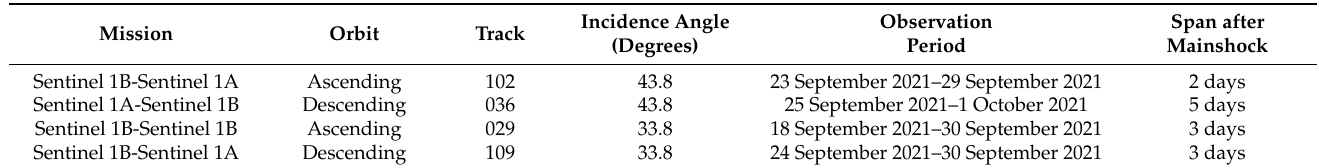
Figure 4. Co-seismic LoS displacement maps, as derived using GEP DIAPASON service, for ascending October 2021) ( c , d ) and the corresponding wrapped differential interferograms ( e , f ). The spatial extend of Sentinel-1 acquisition frames for both geometries are also indicated ( a , b ). The difference in the temporal span following the mainshock (27 September 2021) for the two opposite geometries is worth noting. While A102 spans approx. two days, D036 extends over five days after the earthquake, denoting larger contribution of post-seismic motion. Black lines correspond to fault zones (after [3]). The relocated epicenter of the 27 September 2021 mainshock is marked with a star. Table 1. Overview of the interferometric pairs considered in DInSAR processing, including the LoS incidence angles of the measurements. The time span of each DInSAR pair following the mainshock is also